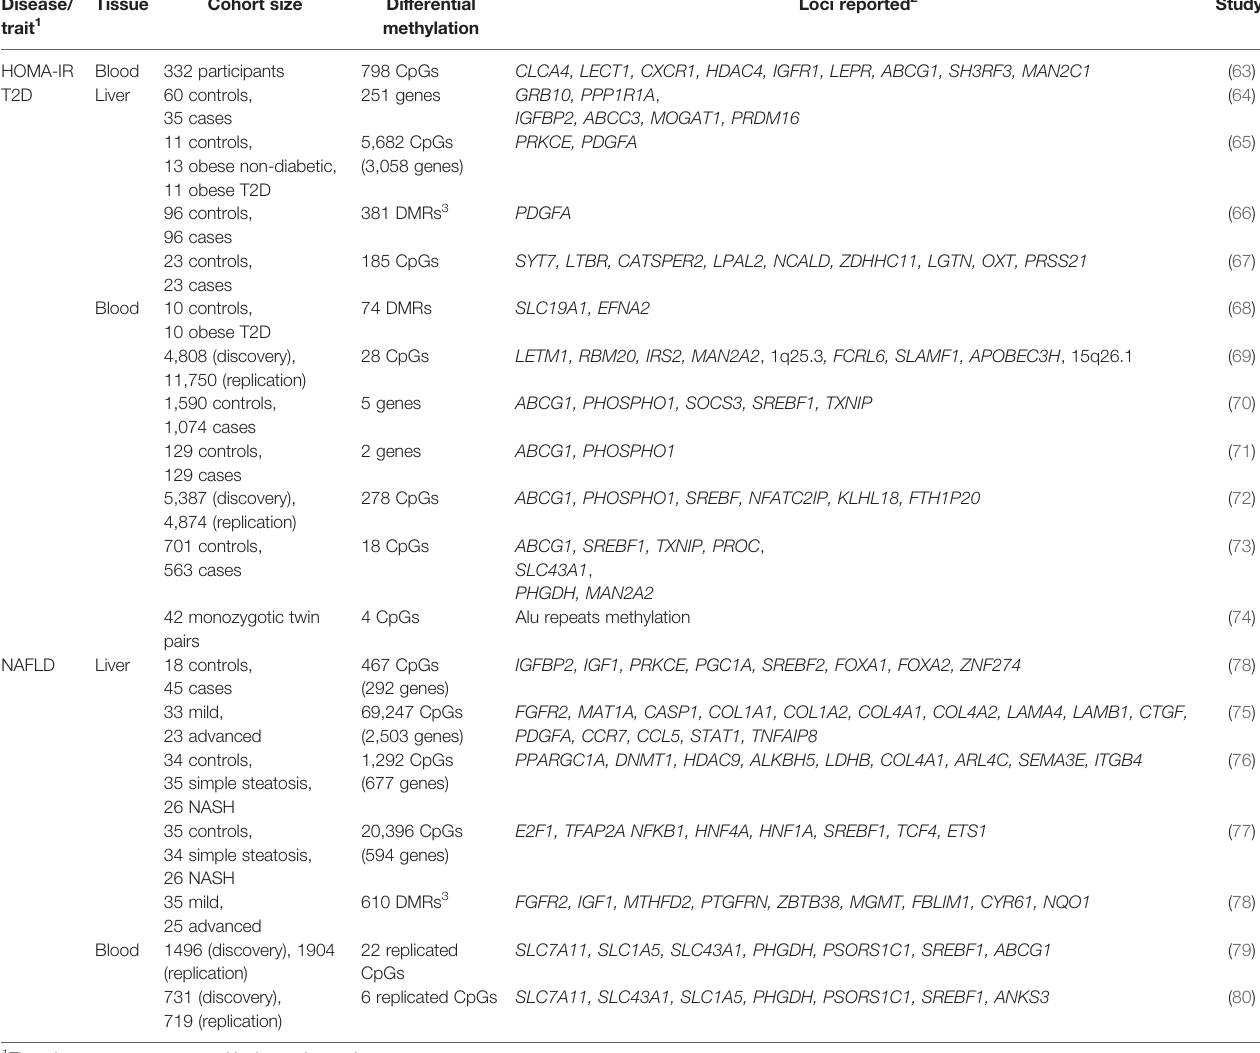
TABLE 2 | EWAS of IR and IR-related